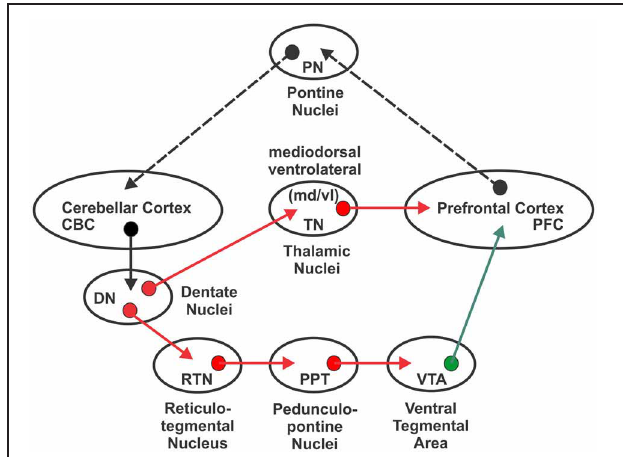
FIGURE 1 | Neural circuitry involved in cerebellar modulation of medial prefrontal cortex dopamine proposed to be affected by a developmental disconnection in autism. With the exception of inhibitory cerebellar to dentate nucleus projections, red arrows indicate glutamatergic pathways. The green arrow indicates the mesocortical dopaminergic pathway. Dotted black arrow indicates feedback loop. See text for additional details and